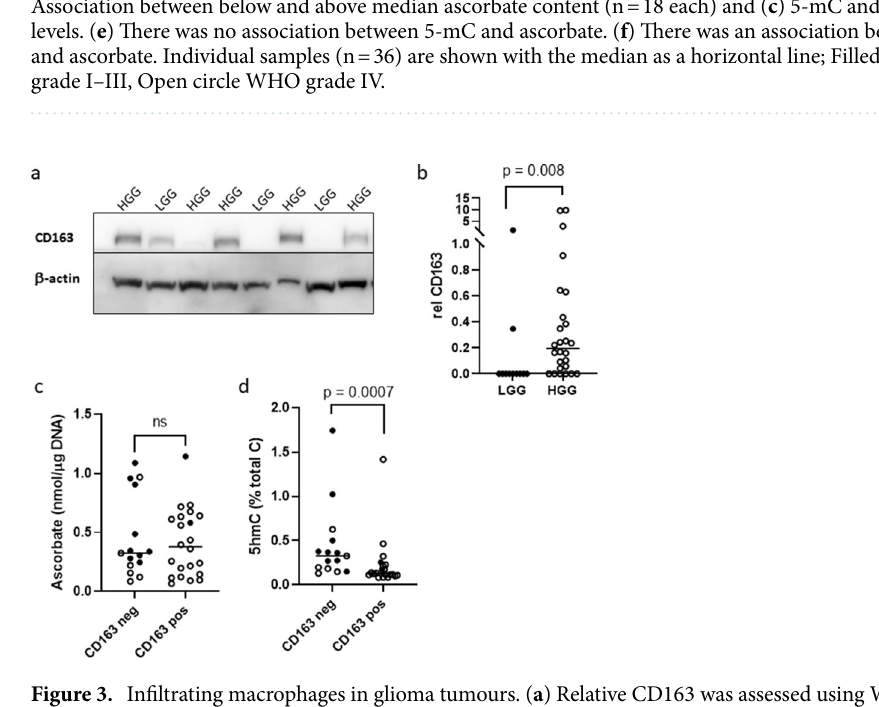
Figure 3. Infiltrating macrophages in glioma tumours. ( a ) Relative CD163 was assessed using Western blotting; a representative blot is shown. ( b ) High grade gliomas (HGG) had higher levels of CD163 than low grade gliomas (LGG), indicating a higher macrophage infiltrate. ( c ) Ascorbate content was similar between CD163 negative and positive tumours. ( d ) Hydroxymethylcytosine (5-hmC) was significantly lower in CD163 positive tumours, Mann Whitney test. Individual samples (n = 36) are shown with the median as a horizontal line; Filled circle WHO grade I–III, Open circle WHO grade IV; T, tumour; ns not